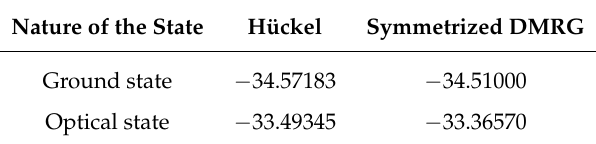
Table 1. Ground and lowest optical state energies of coronene within the non-interacting Hückel model, in units of t 0 , calculated using the Hückel and symmetrized DMRG